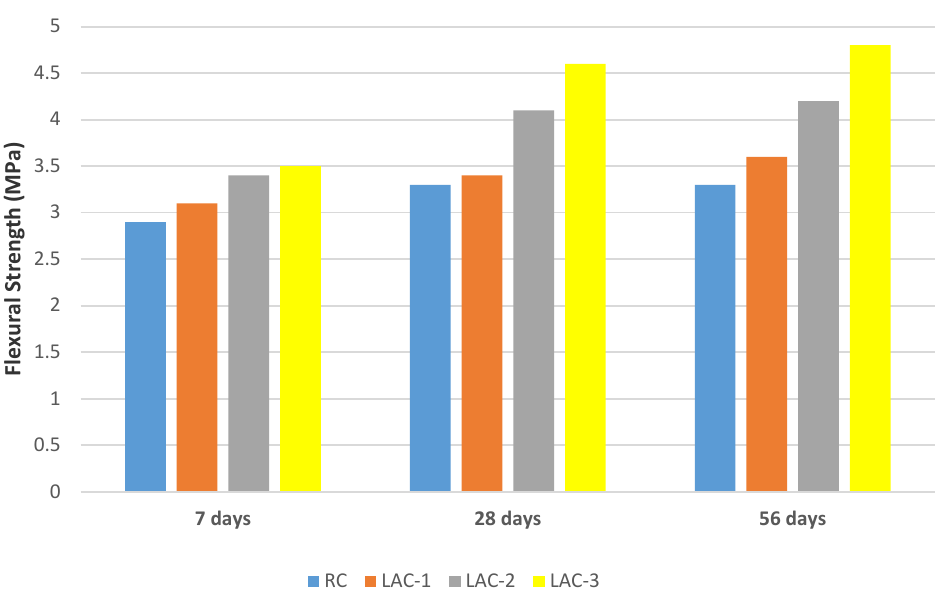
Figure 9. The flexural strength test results of the mixes.